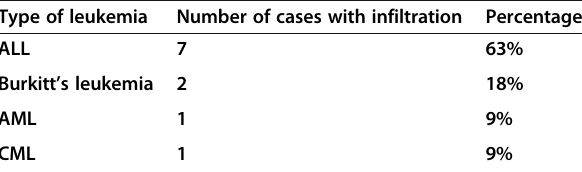
Table 4 Correlation between type of leukemia and rate of